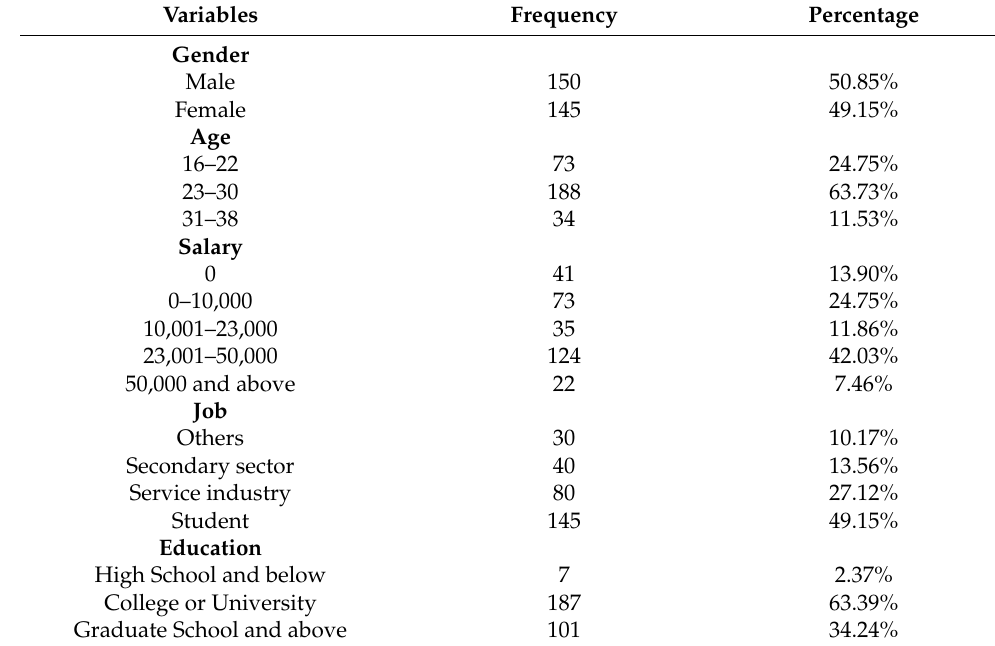
Table 1. Socio-demographic characteristics of the